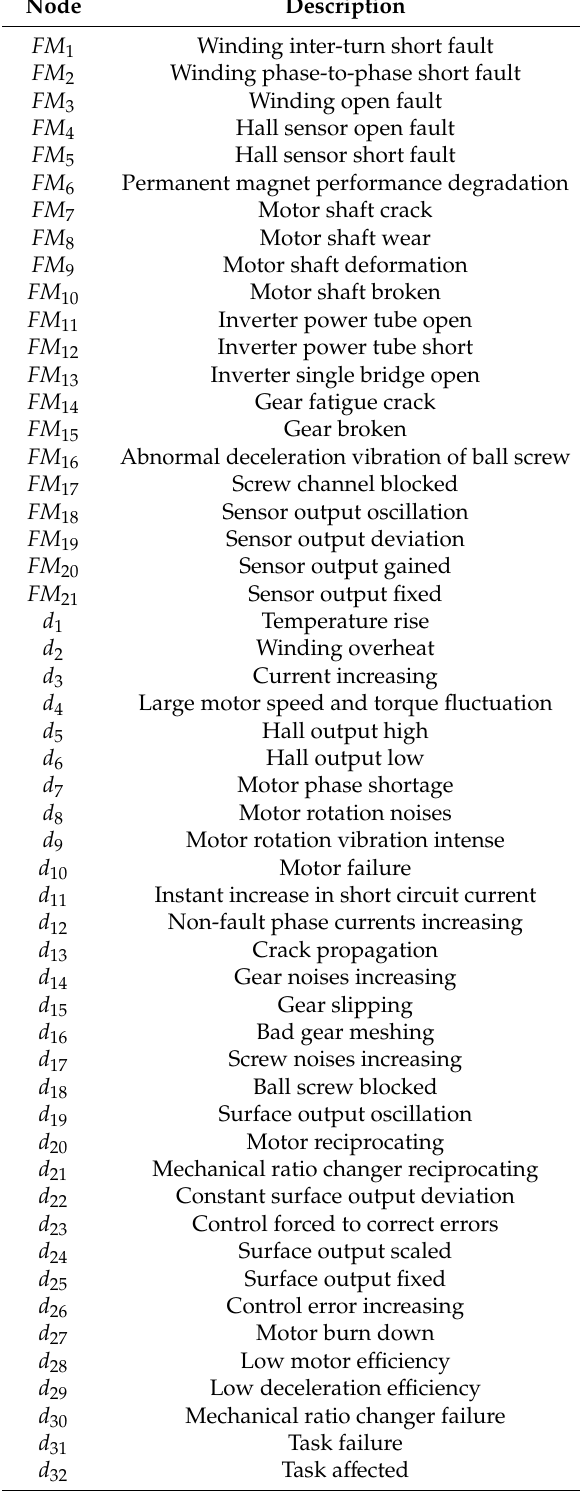
Table A1. Descriptions of nodes in the TFPG model of the